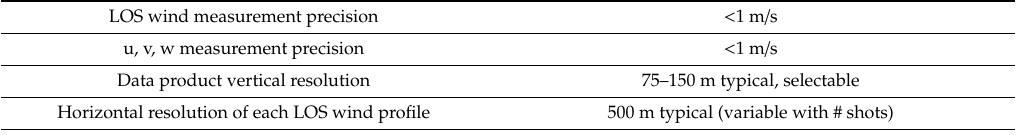
Table 5. DAWN measurements, precision and resolutions.